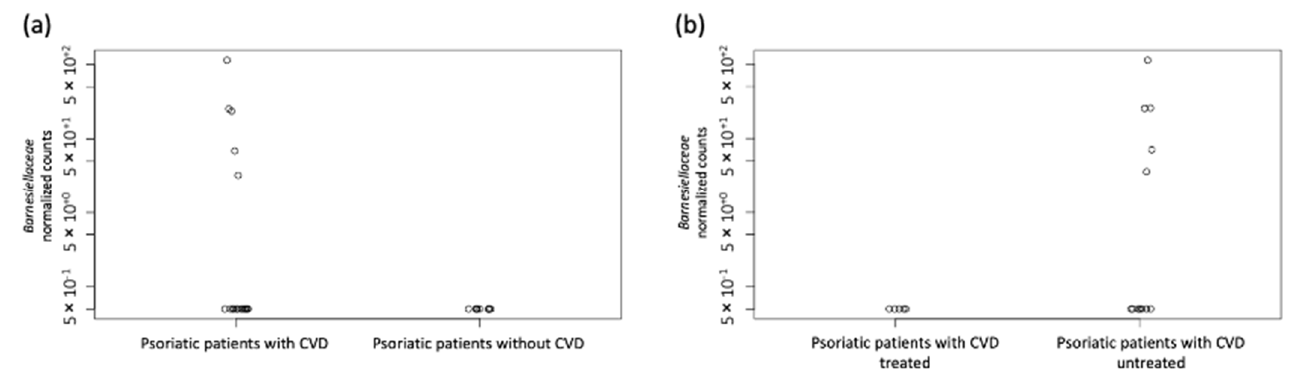
Figure 2. The abundance of the family Barnesiellaceae in psoriatic patients analyzed in this study. ( a ) Levels of the family Barnesiellaceae in the gut microbiome of psoriatic patients with and without CVD. ( b ) Levels of the family Barnesiellaceae in the gut microbiome of psoriatic patients with CVD treated and untreated with biological therapy. Each circle in the figure represents a psoriatic patient. CVD: cardiovascular disease.